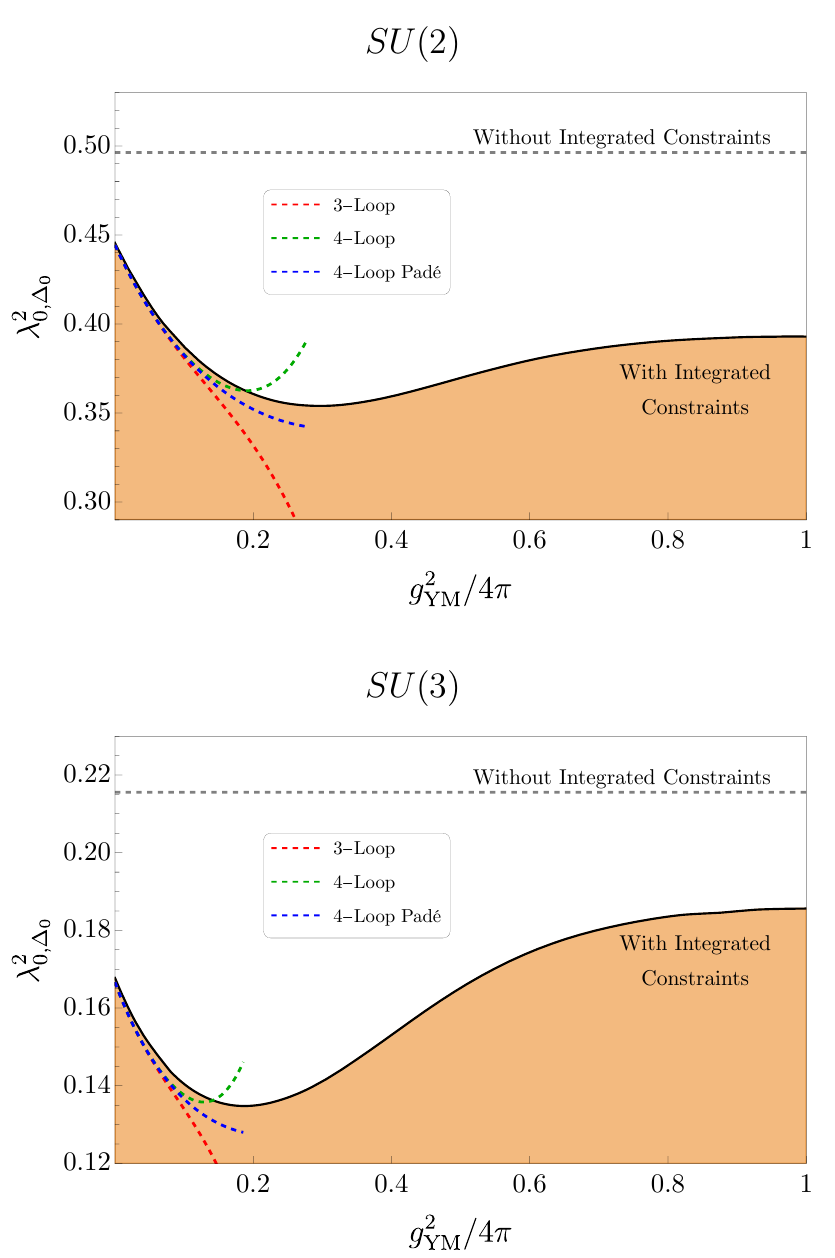
Figure 9 . Upper bounds on the OPE coefficient of the lowest scalar for SU (2) and SU (3) as a function of g 2 at θ = 0 , obtained with bootstrap resolution Λ = 39 . We plot from g 2 YM self-dual point at g 2 = 4 π . The weak-coupling estimates for these coefficients are included, showing YM that our bounds are nearly saturated by these values at small g 2 that would be obtained at the same bootstrap resolution without using the integrated constraints, and without using bounds on the scaling dimensions obtained with integrated constraints. Note that, like the localization inputs, the slope of these upper bounds go to zero at the Z 2 self-dual point g 2 = 1 YM